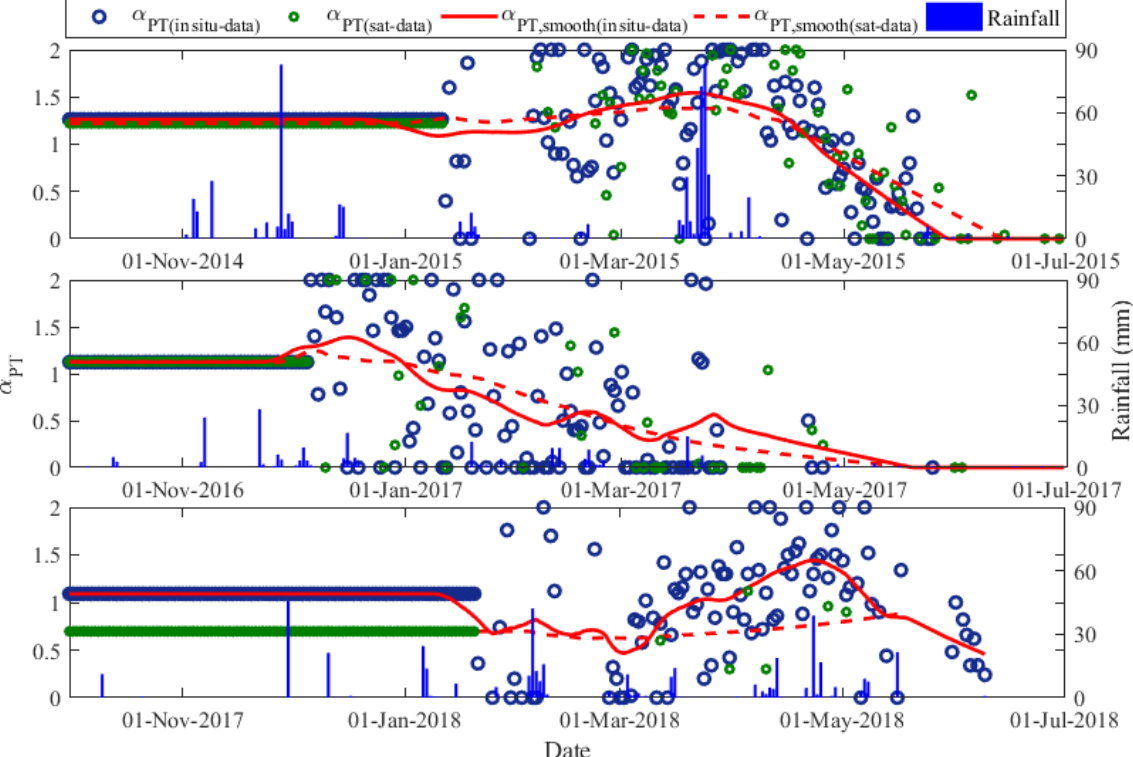
Figure 6. Time series of daily retrieved and smoothed α PT (calibration step 2 – using in situ data and satellite data) collected during S1, S2 and